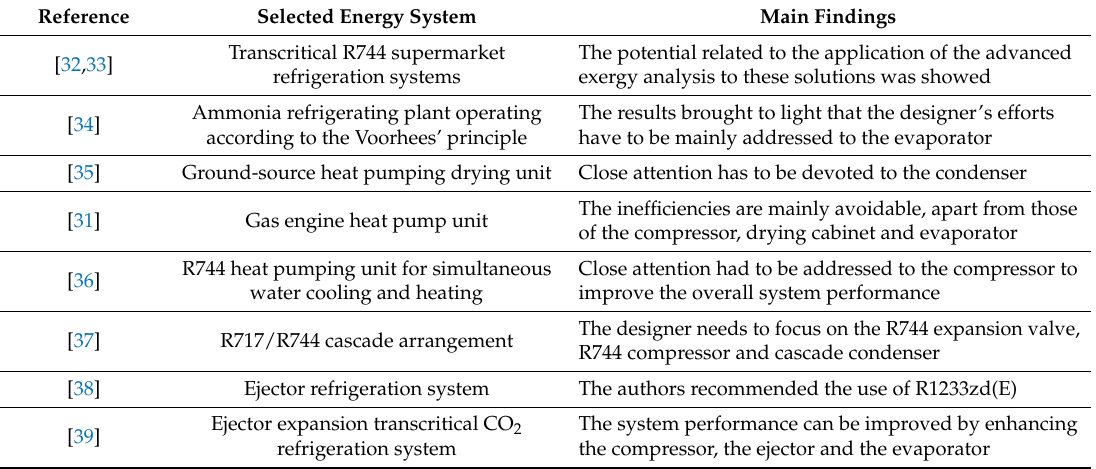
Table 2. Findings of the main investigations associated with the advanced exergy